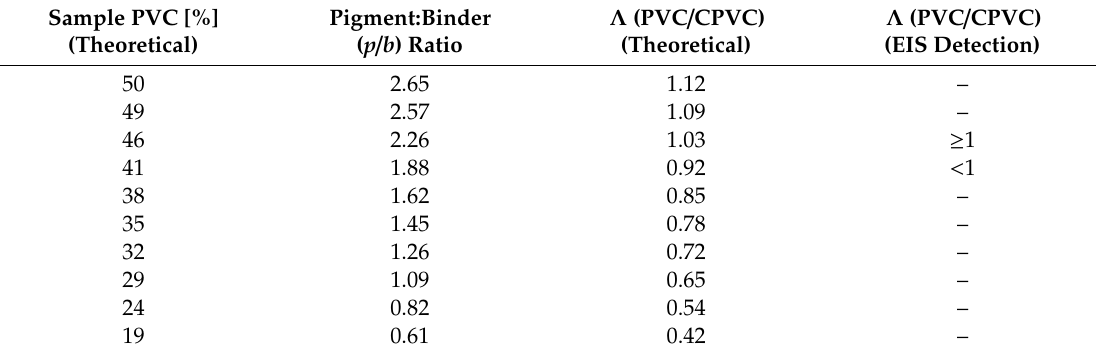
Table 1. Labeling of samples with di ff erent pigment volume concentration (PVC) values (in % vs. theoretical value) and the corresponding reduced PVC values ( Λ ). The PVC-critical pigment volume concentration (CPVC) transition ( Λ = 1) is theoretically expected at a PVC of 44.75%. The last column indicates detection of the ratio PVC:CPVC (often denoted as Λ ) using electrochemical impedance spectroscopy (EIS) (for details see Results and Discussion